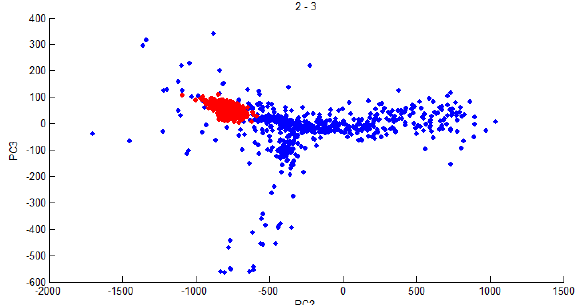
Figure 2. Decorrelated inputs for SVM training with road (red dots) and non-road (blue dots) samples